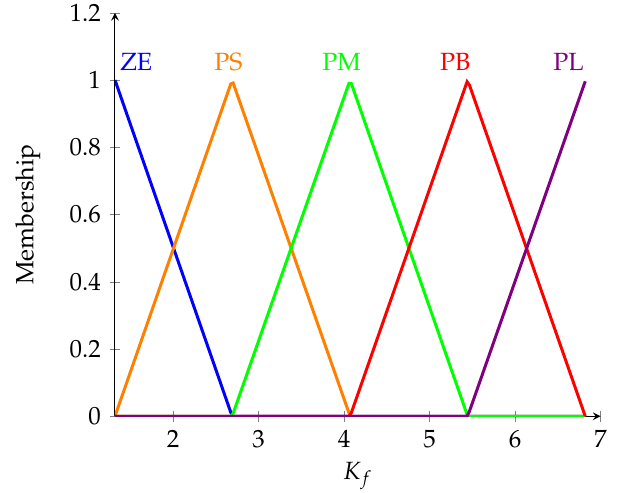
Figure 5. The output membership functions for K f for the